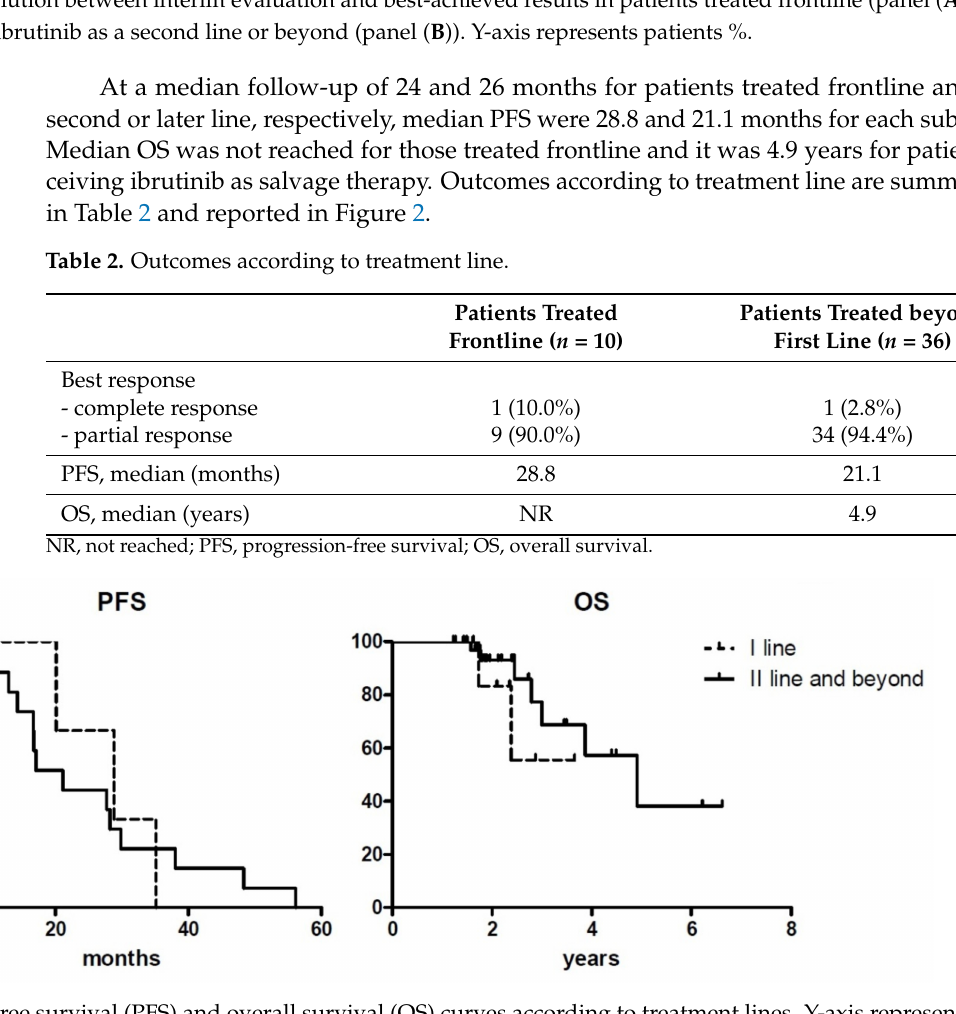
Figure 2. Progression-free survival (PFS) and overall survival (OS) curves according to treatment lines. Y-axis represents patients % of